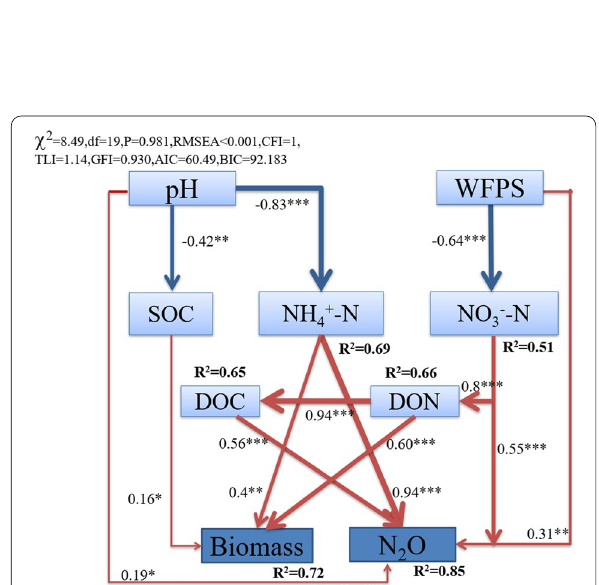
Fig. 7 Ordinary least-squares regressions between the vegetable dry biomass, dissolved organic N and NO 3 − -N content; N 2 O cumulative emission, NH 4 + -N content and